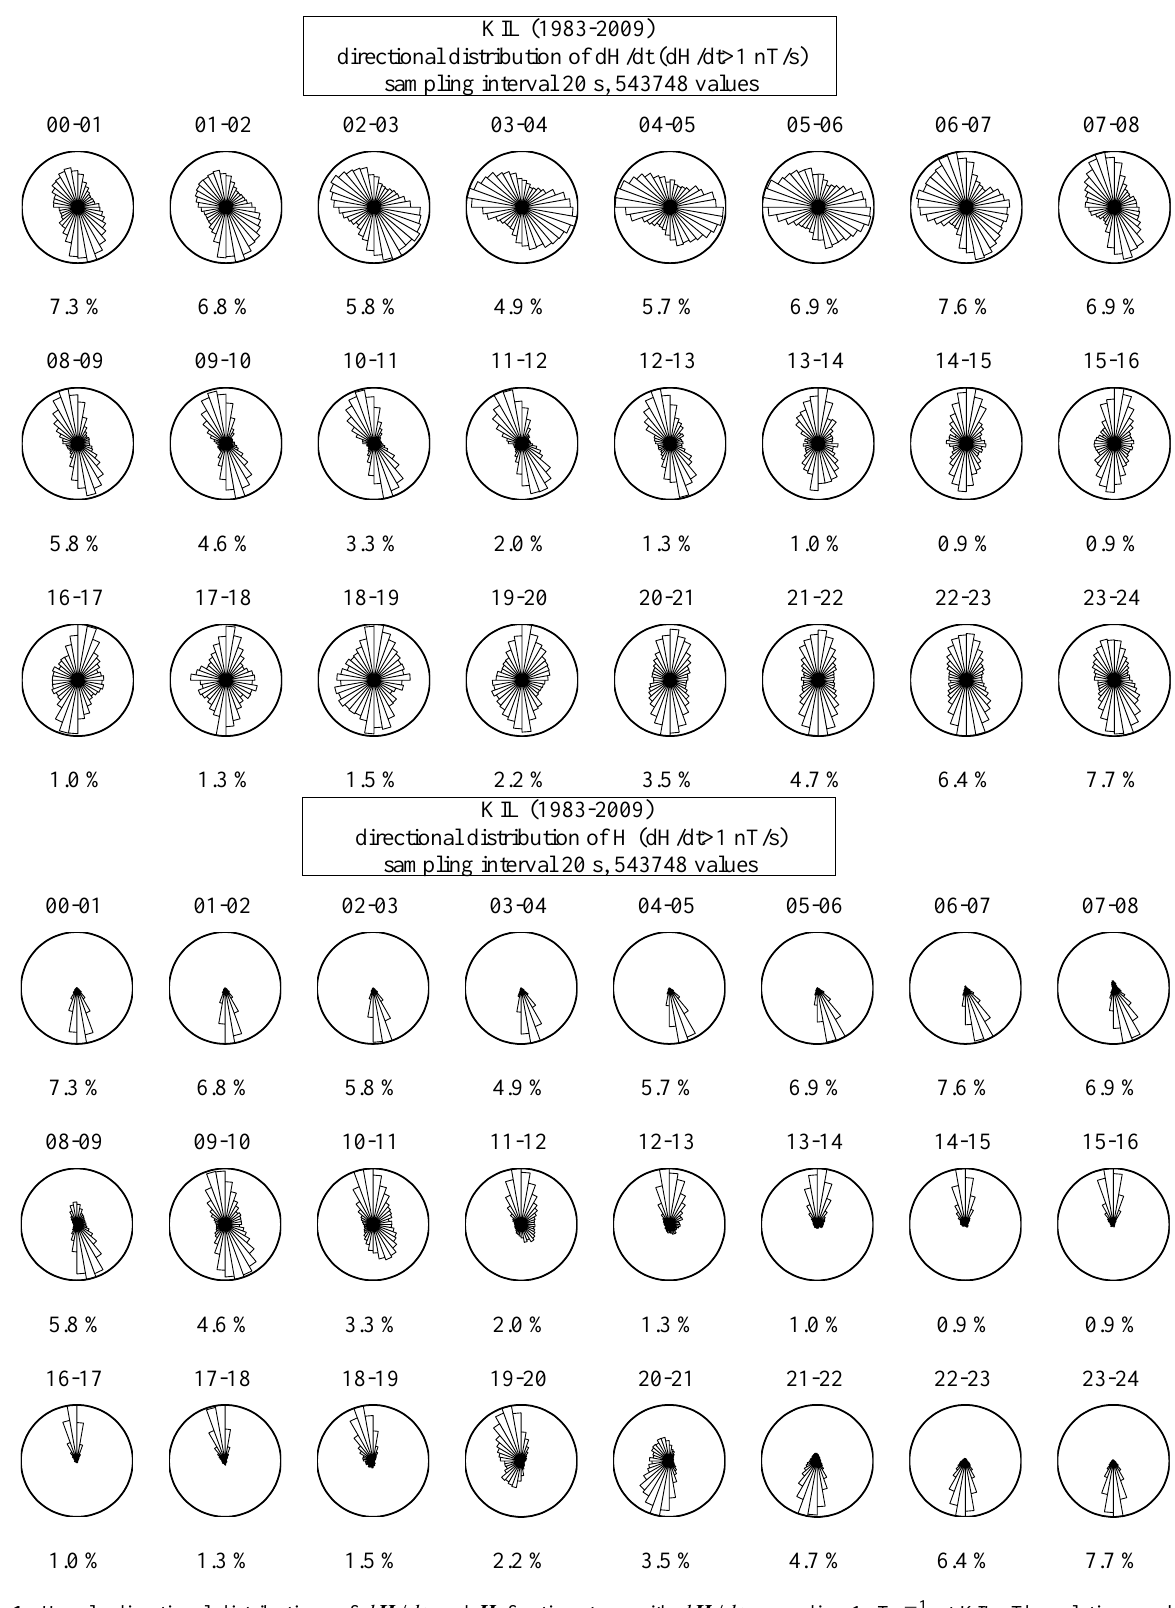
Fig. 1. Hourly directional distributions of d H /dt and H for timesteps with d H /dt exceeding 1nTs − 1 at KIL. The relative number of contributing d H /dt values is given below each diagram. The geographic north is up and east to the right. Magnetic local time is